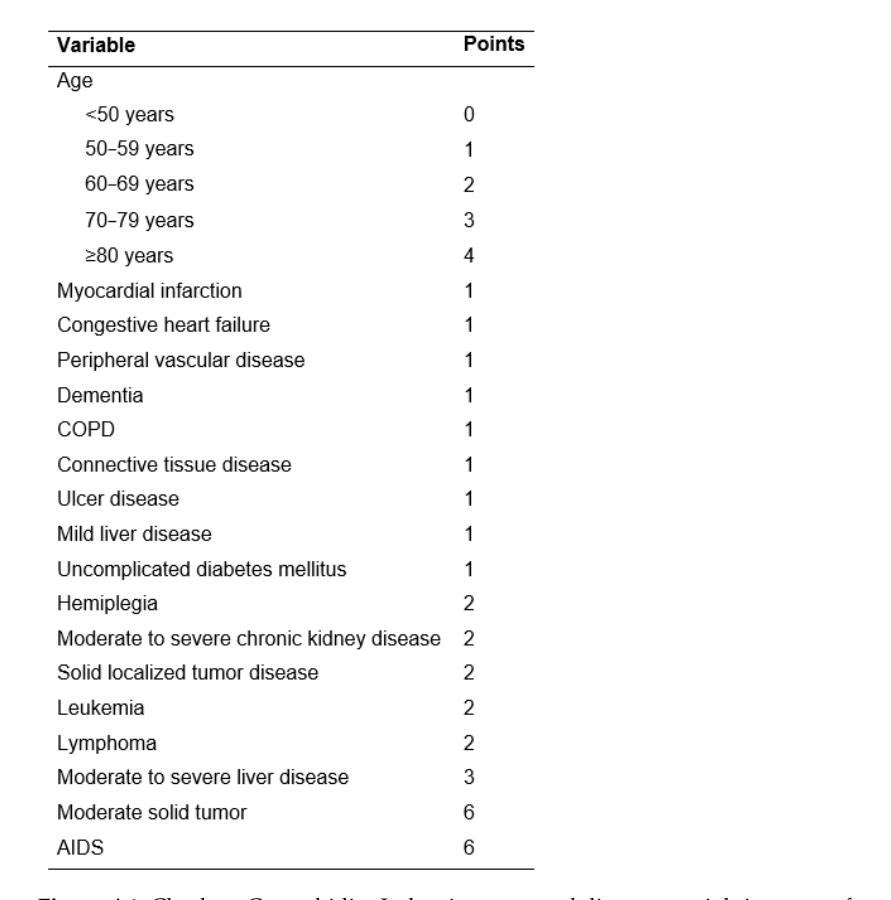
Figure A1. Charlson Comorbidity Index; incorporated diseases, weighting range from 1 to 6 points. To adjust for age, every decade after 40 years is reflected by 1 point (maximum weight for age: 4 points).